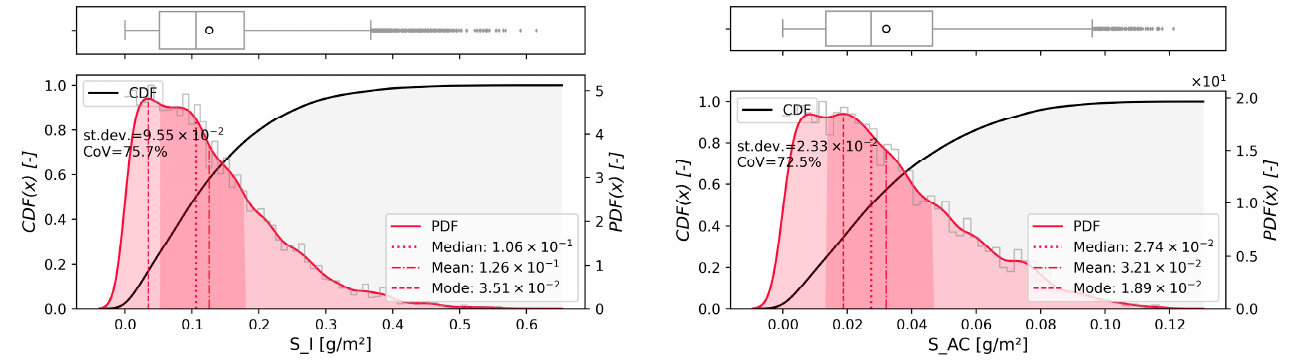
Figure 6. PDFs, CDFs, and box-whisker plots of S I and S AC .